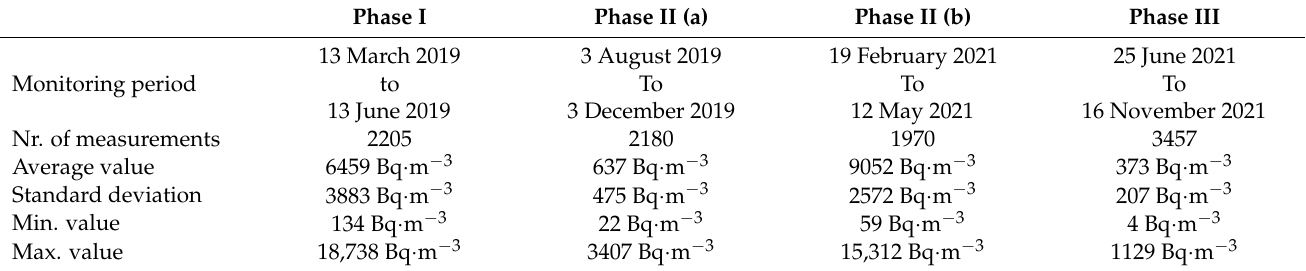
Table 2. Summarized data obtained from the monitoring phases of indoor Rn concentration,